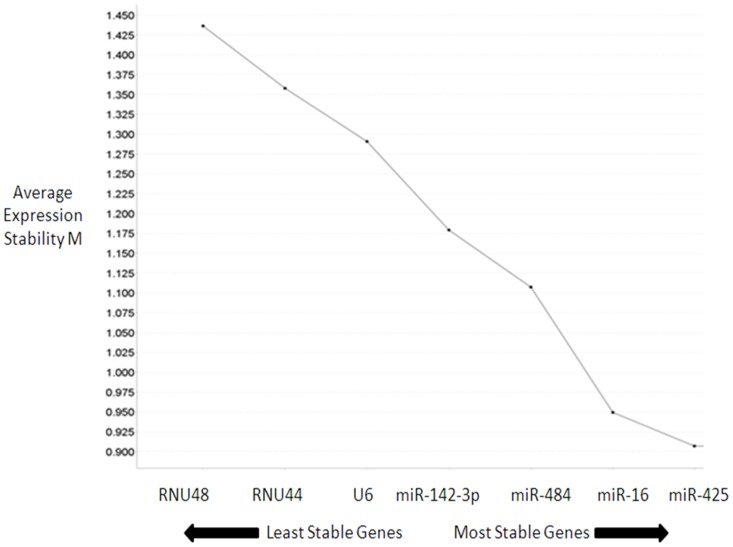
GeNorm analysis of average expression stability of candidate ECs.Ranking of candidate ECs according to average expression stability. The least stable candidate ECs with the highest stability measure (M) are on the left side of the graph, with the most stable ECs with the lowest M value on the right. RNU48 and RNU44 are the least stable ECs while miR-425 and miR-16 are the most stable candidate ECs.